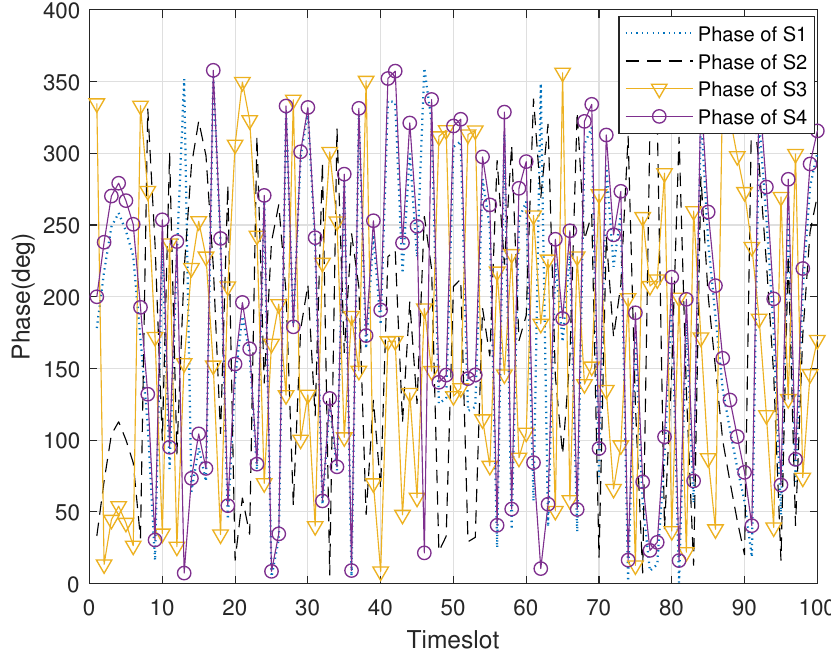
Figure 4. The signal phase of each concomitant satellite versus timeslot without phase control.